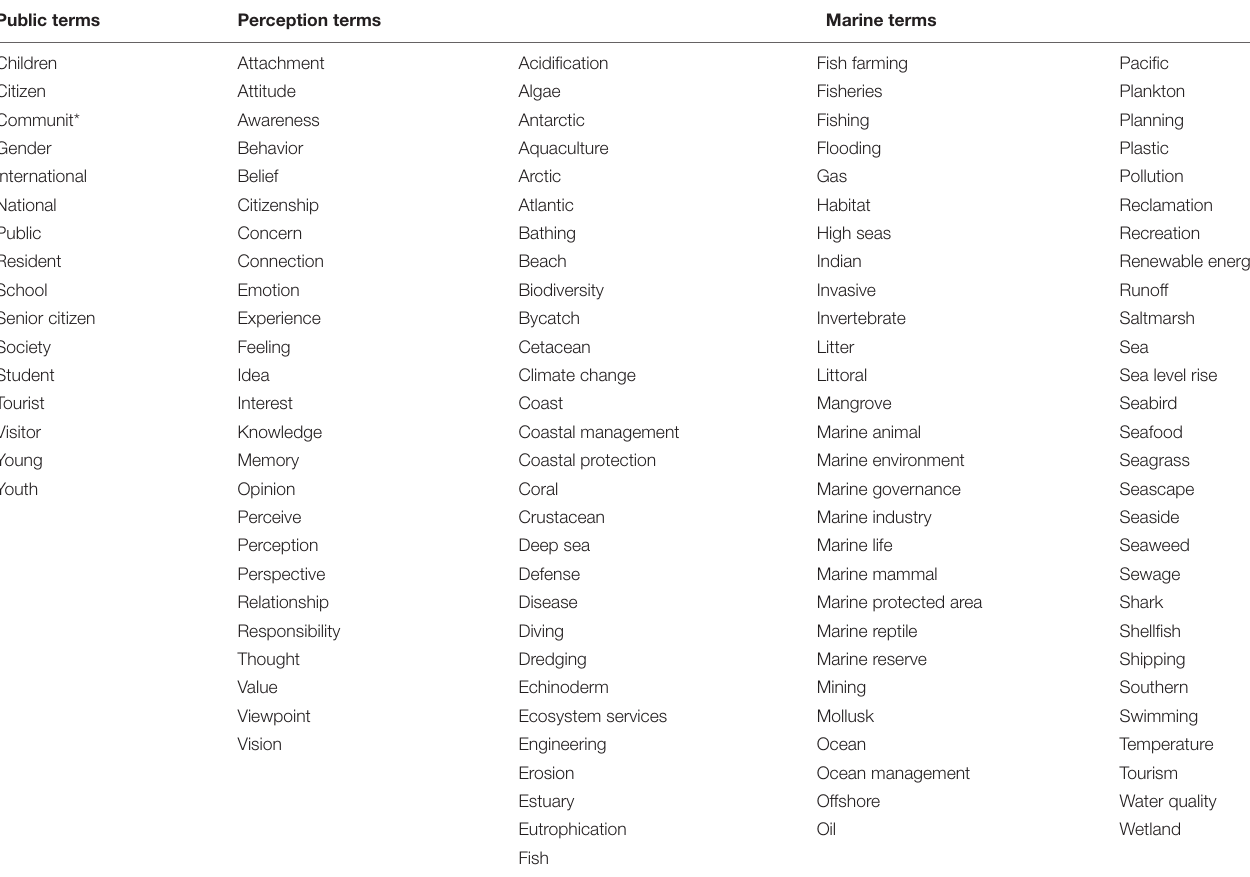
TABLE 1 | Search terms used to identify research on public perceptions of the